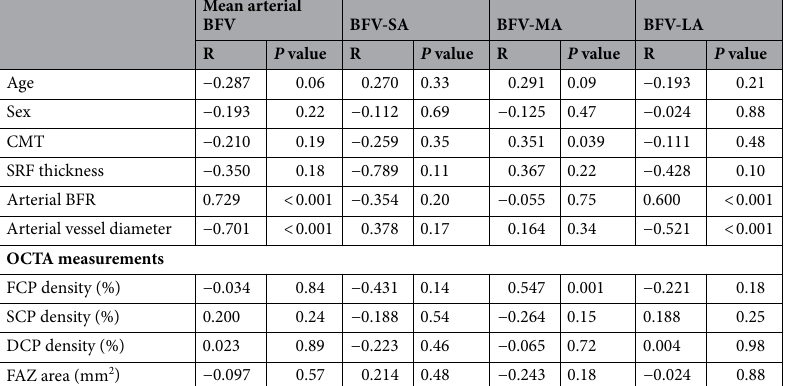
Table 2. Arterial blood flow velocity and its associated factors. All P values were calculated using Pearson’s correlation test. BFR blood flow rate, BFV blood flow velocity, BFV-SA small arteriole blood flow velocity (diameter smaller than 40 μm), BFV-MA middle arteriole blood flow velocity (diameter between 40 and 80 μm), BFV-LA large arteriole blood flow velocity (diameter greater than 80 μm), CMT central macular thickness, CSC central serous chorioretinopathy, DCP deep capillary plexus, FAZ foveal avascular zone, FCP full capillary plexus, OCTA optical coherence tomography angiography, SCP superficial capillary flexus, SRF subretinal